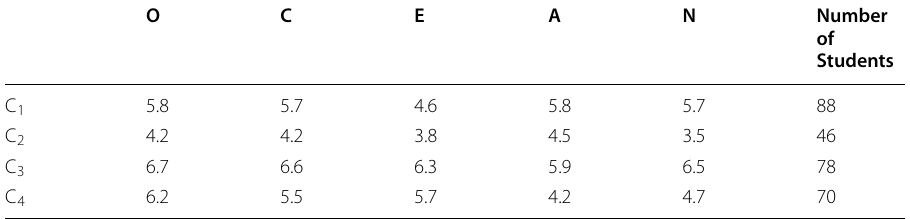
Table 5 Student clusters based on personality traits